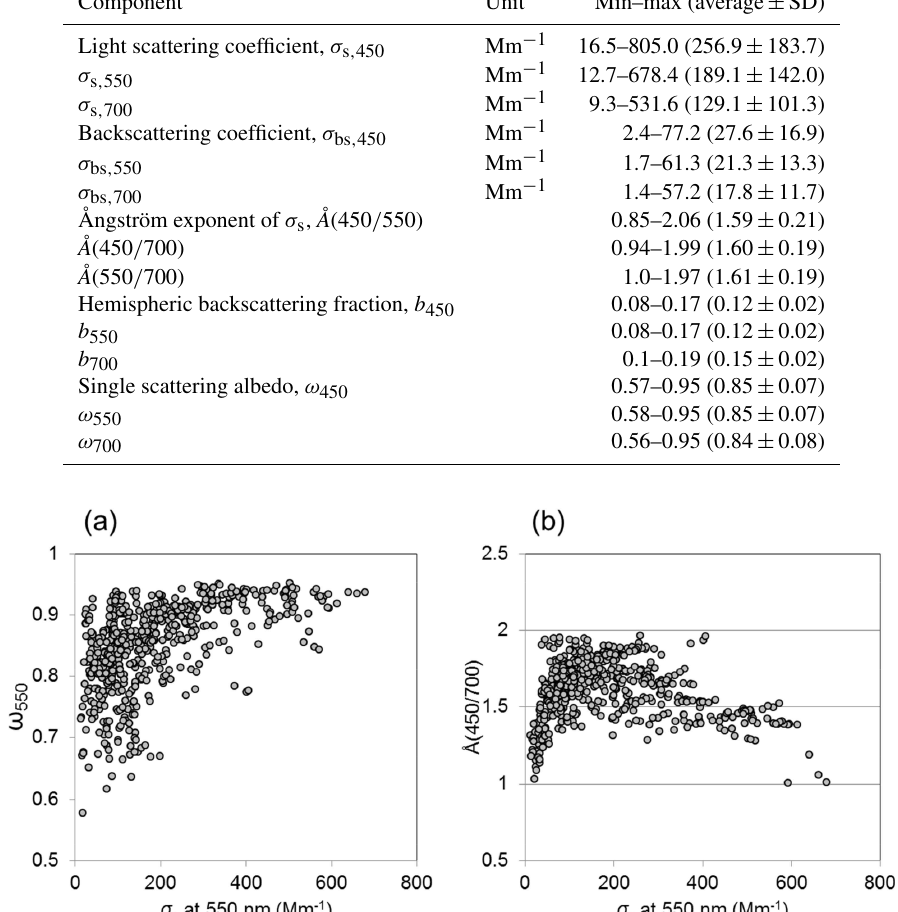
Table 1. Summary of aerosol optical parameters observed in Daejeon, South Korea, during January 2014. Component